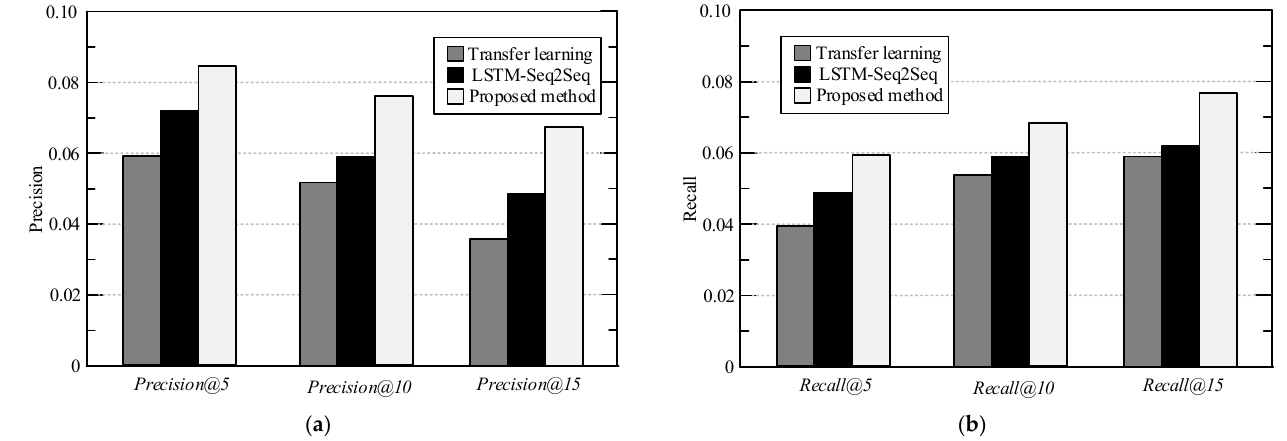
Figure 3. Experimental comparison results on loc-Gowalla data set ( a ) precision ( b ) recall.